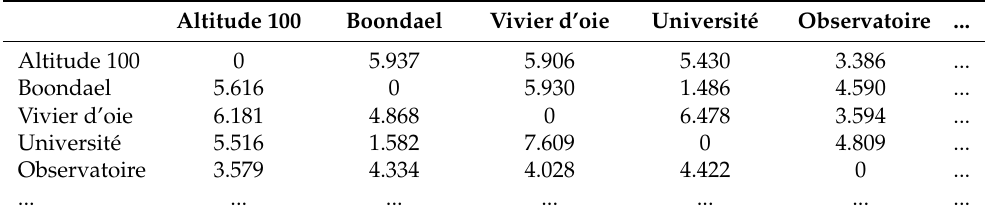
Table 1. Distances (in km) between each pair of the five neighborhoods presented above using the BingMaps API. Traffic conditions: Monday morning (7